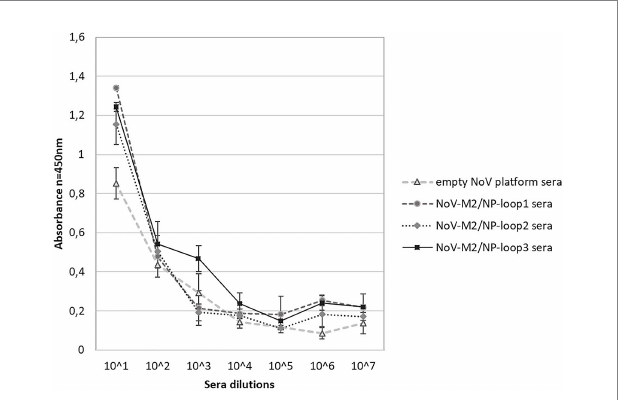
FIGURE 8 Characterization of immune response after immunization with NoV-M2/NP VLPs toward universal influenza epitopes recognition. ELISA plates were coated with an inactivated virus for influenza A virus of H1N1, H5N2, and H7N1 strains. For each ELISA, the mean value from three independent experiments performed is presented. The mean A450 values and standard deviations are shown on the y-axis.